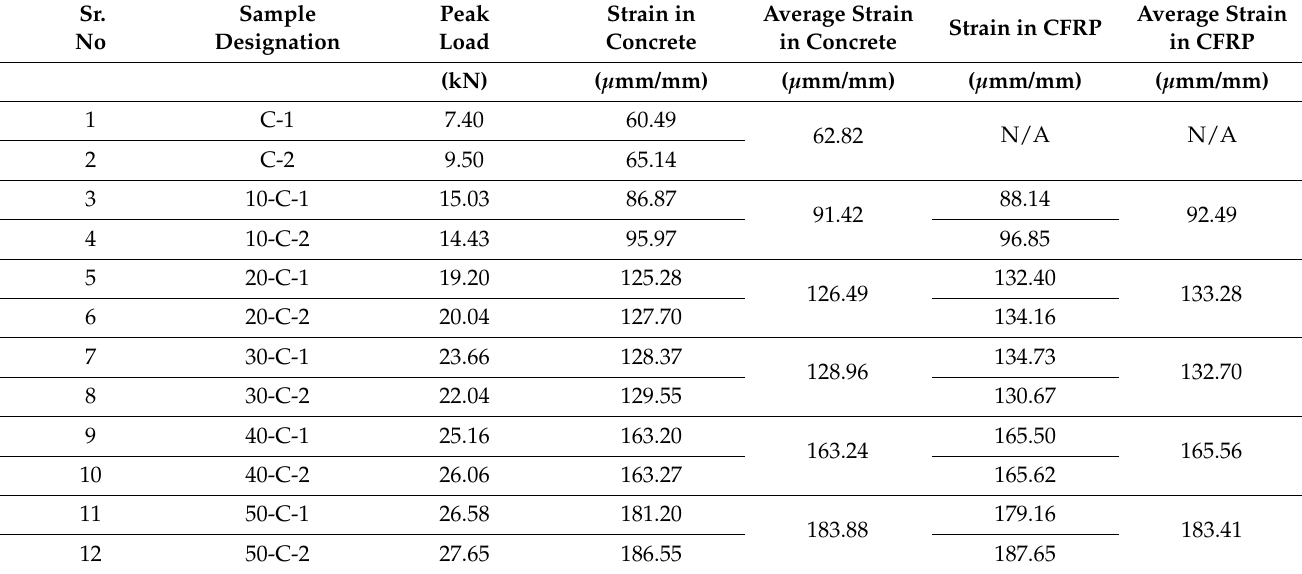
Table 6. Experimental results summary of strain in concrete and